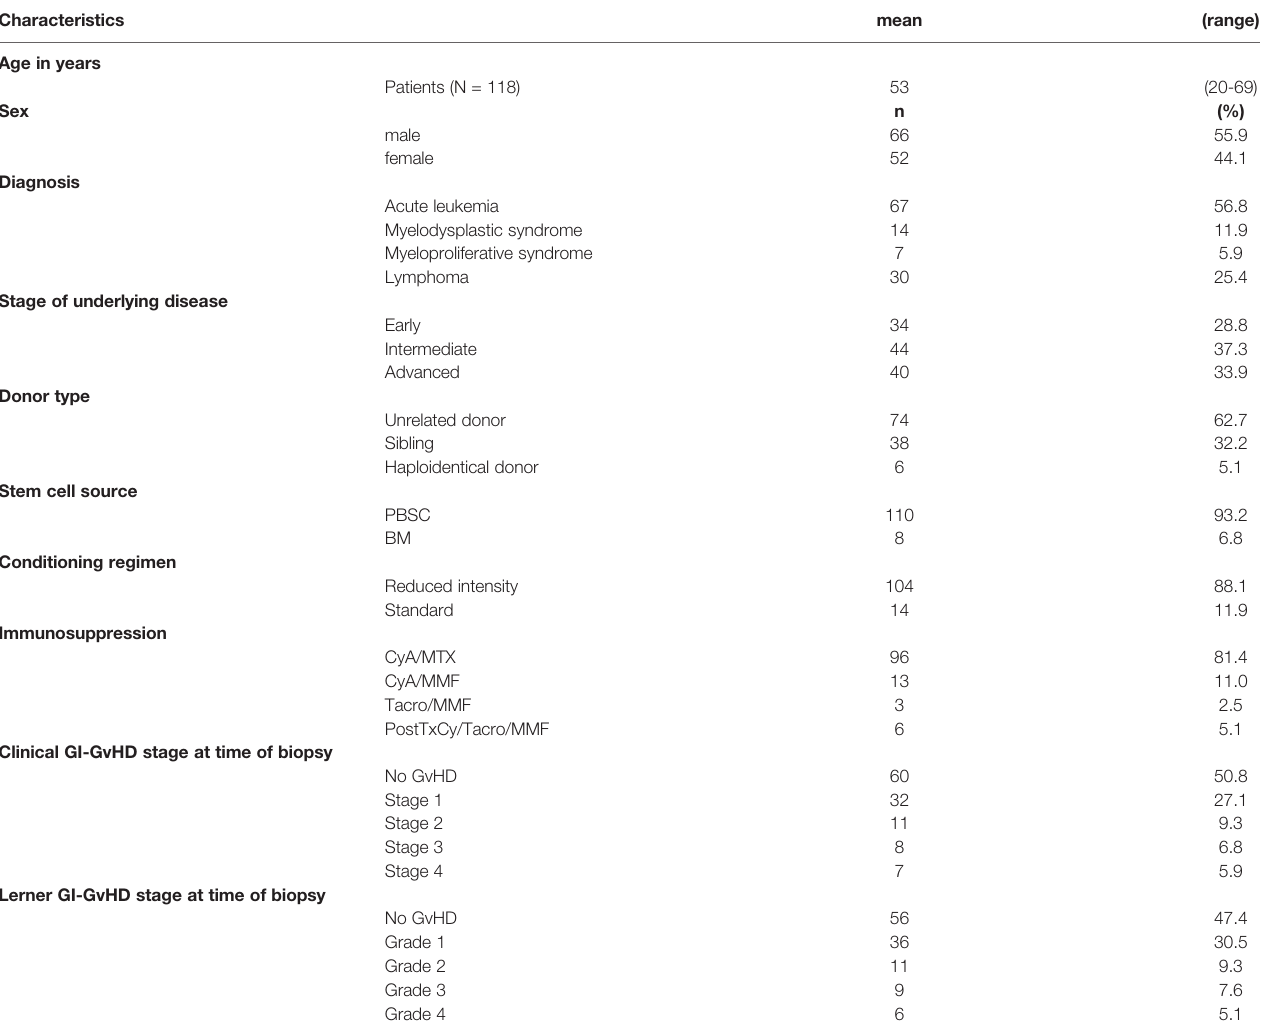
TABLE 1 | Summary of patient characteristics.